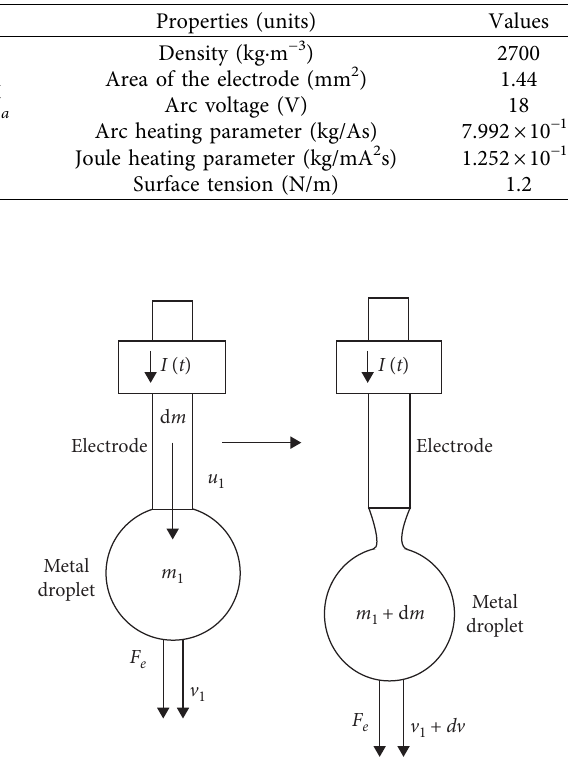
Figure 4: Variable mass system of droplet